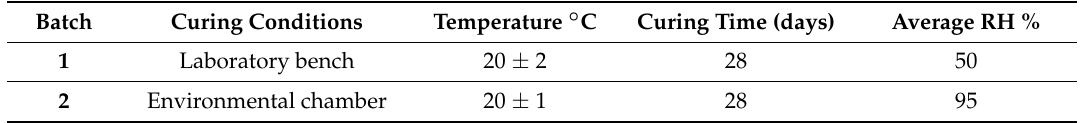
Table 3. Curing conditions of geopolymer coatings, divided in two